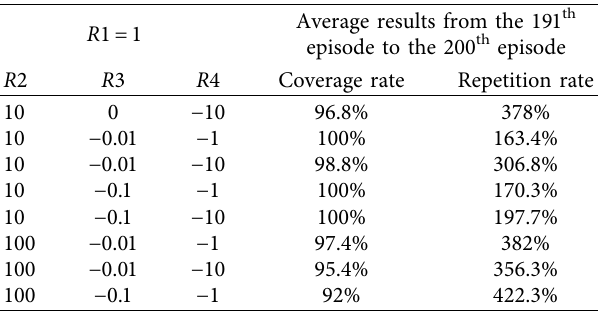
Figure 3: Grid-based map presentation (a) Initial environment. (b) Environment after processing. (c) The robot in processed environment. Table 1: The average results of the last ten episodes when reward parameters